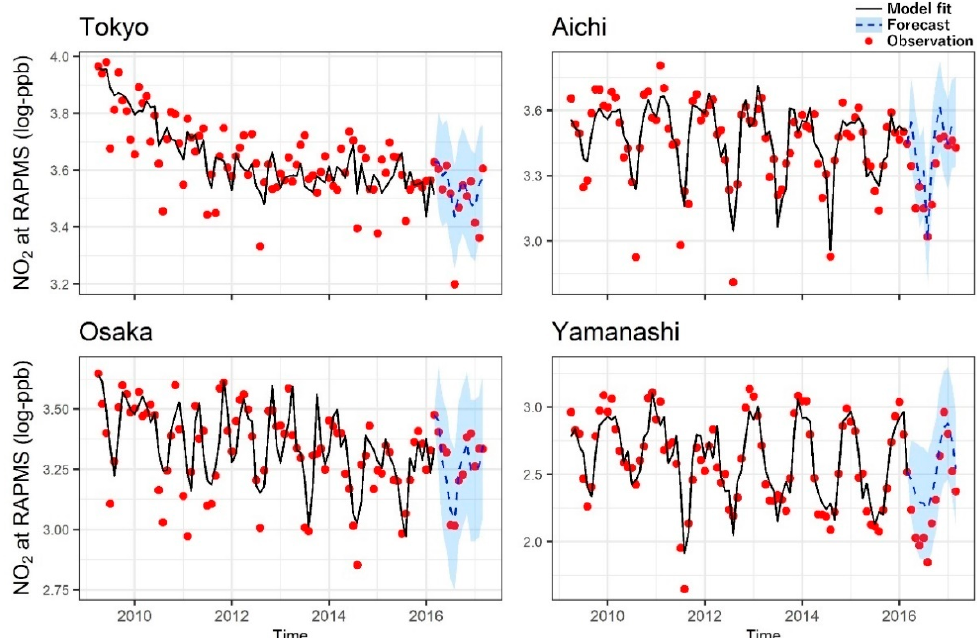
Figure 3. Fitting and forecasting for nitrogen dioxide (NO 2 ) concentration at roadside air pollution monitoring stations (RAPMSs) using seasonal autoregressive integrated moving average (SARIMA) models. Log scale NO 2 concentrations were used for the analyses. Red dots are observations. Black lines show model fits for NO 2 using data in April 2009–March 2016 (training data). Blue dotted lines (estimates) and shadows (95% confidence intervals) show the forecasting for NO 2 using data in April 2016–March 2017 (testing data).